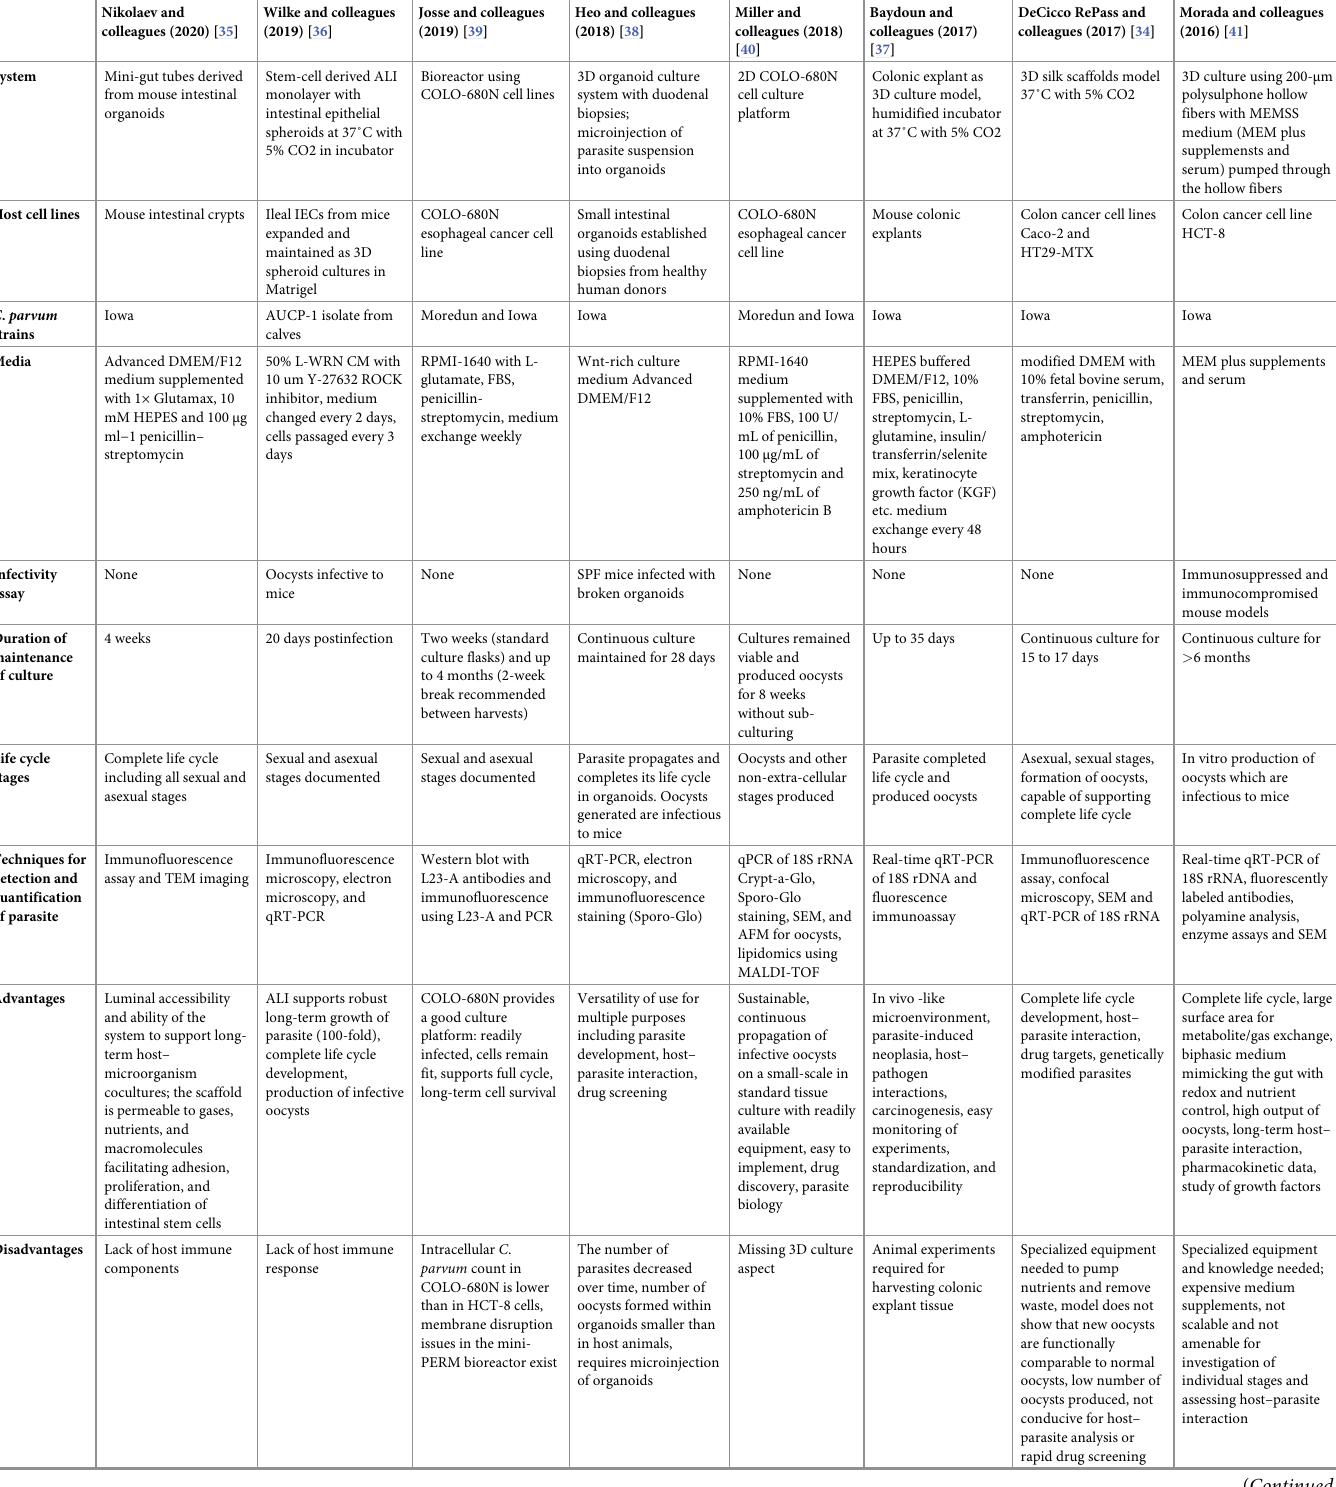
Table 2. Recent advances in the field of in vitro culture systems for Cryptosporidium parvum